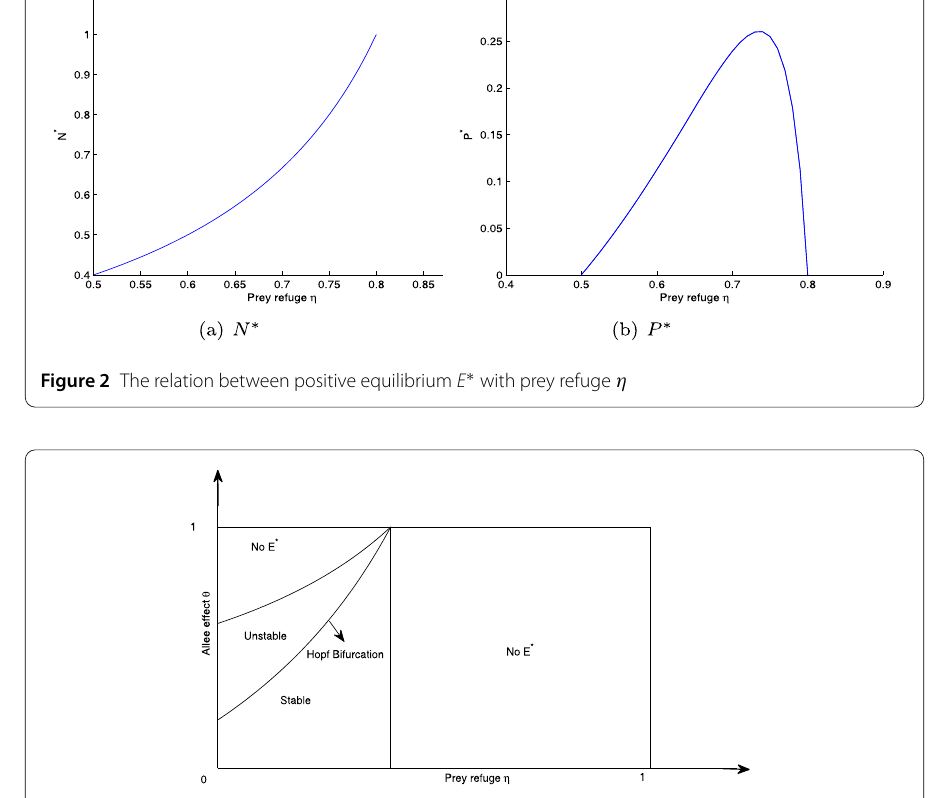
Figure 3 The regions of the existence and stability of positive equilibrium E ∗ in ( η , θ ) plane when m < θ < 1